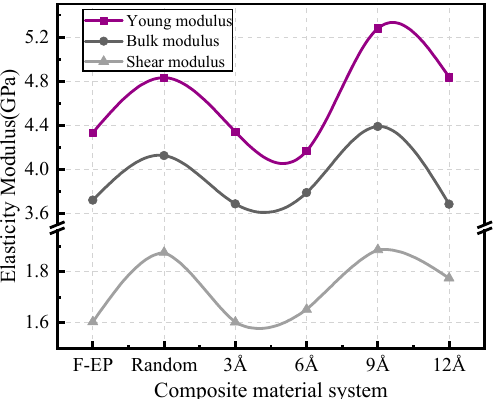
Figure 3. Static elastic modulus of FGO/F ‐ EP composites with different distribution characteristics.